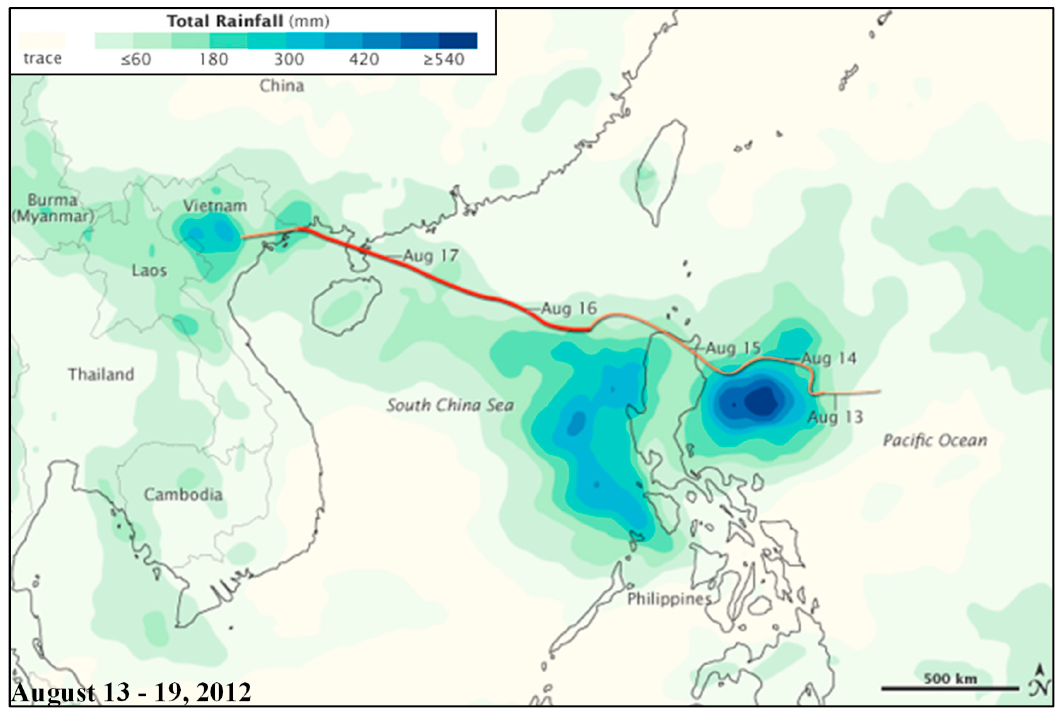
Figure 3. Rainfall from typhoon Kai-tak (2012) based on the NASA Earth Observatory image.